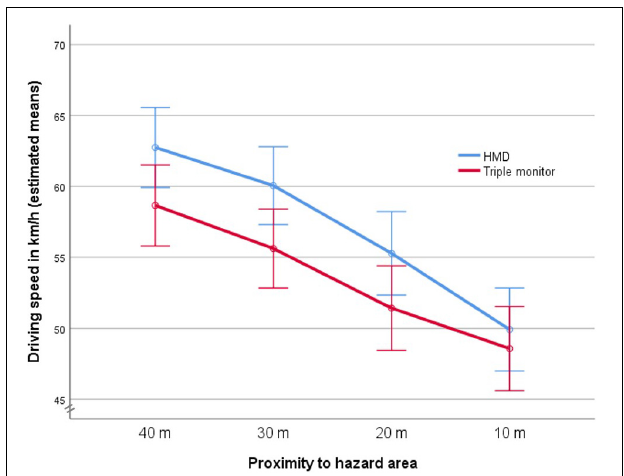
FIGURE 2 | Approaching the hazard area in the two visual display conditions (error bars: + / − 2SE).